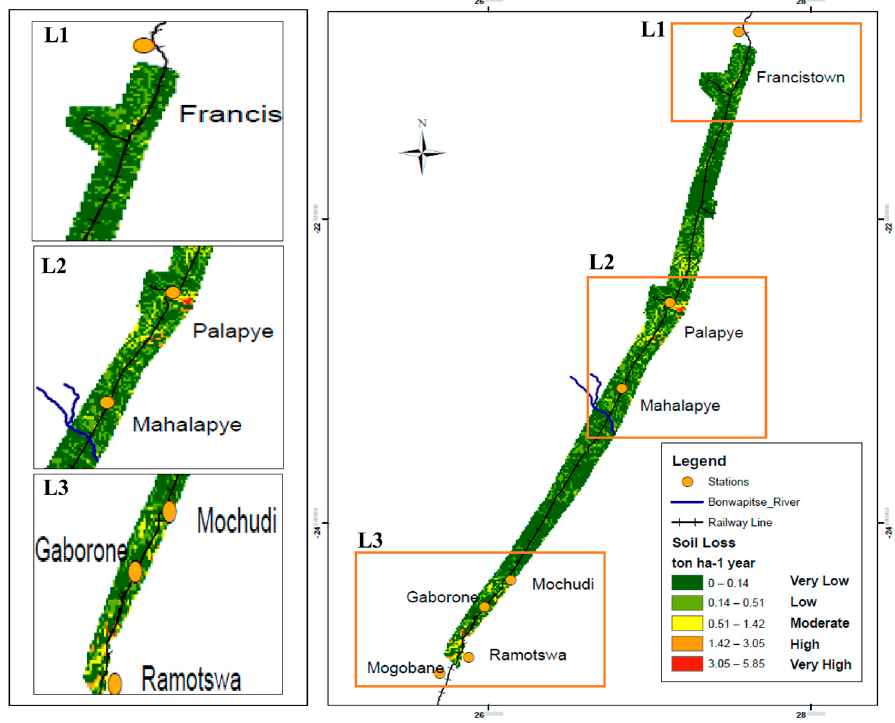
Figure 8. Annual soil loss and soil loss index in the BRC using RUSLE.